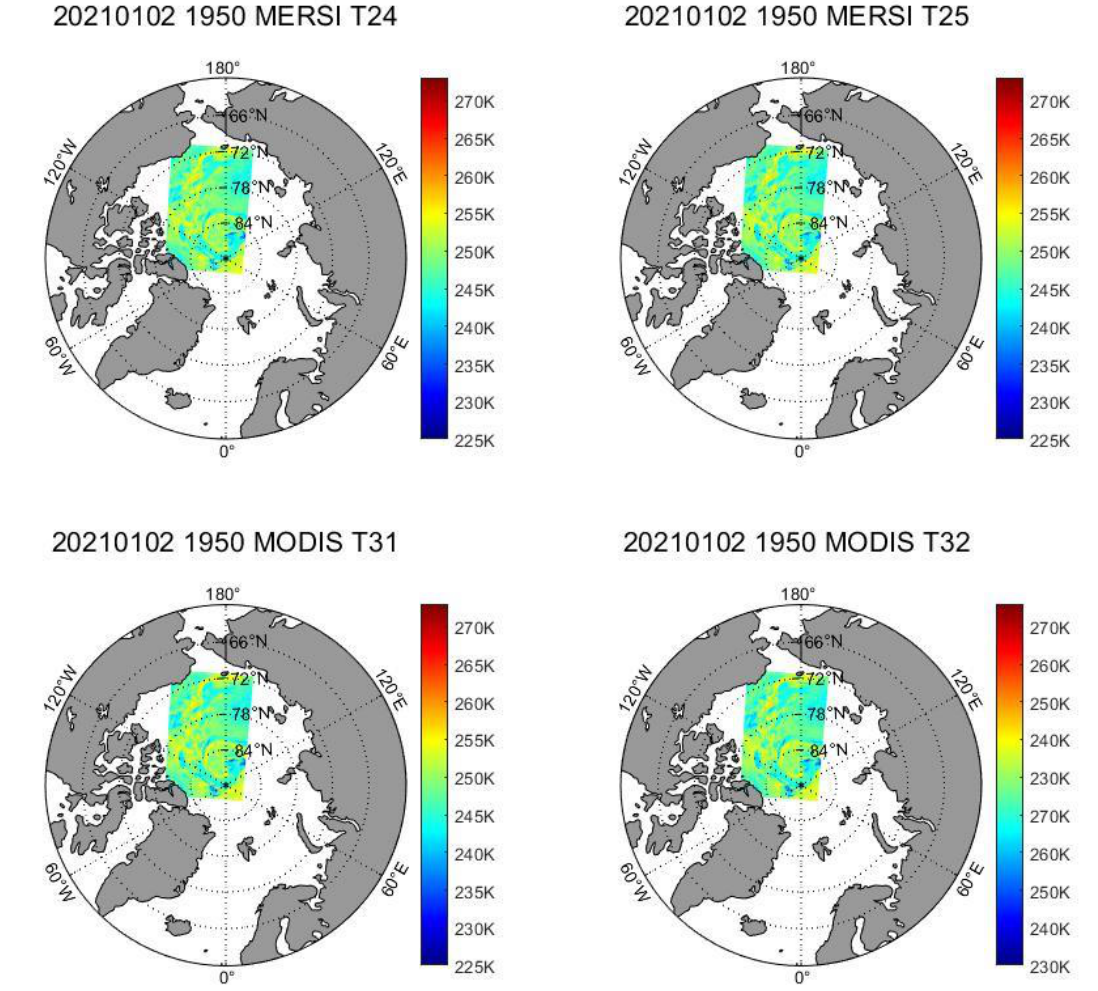
Figure 3. MERSI (channels 24 and 25) and MODIS (channels 31 and 32) thermal infrared T b data after spatial matching at 19:50 on 2 January 2021.